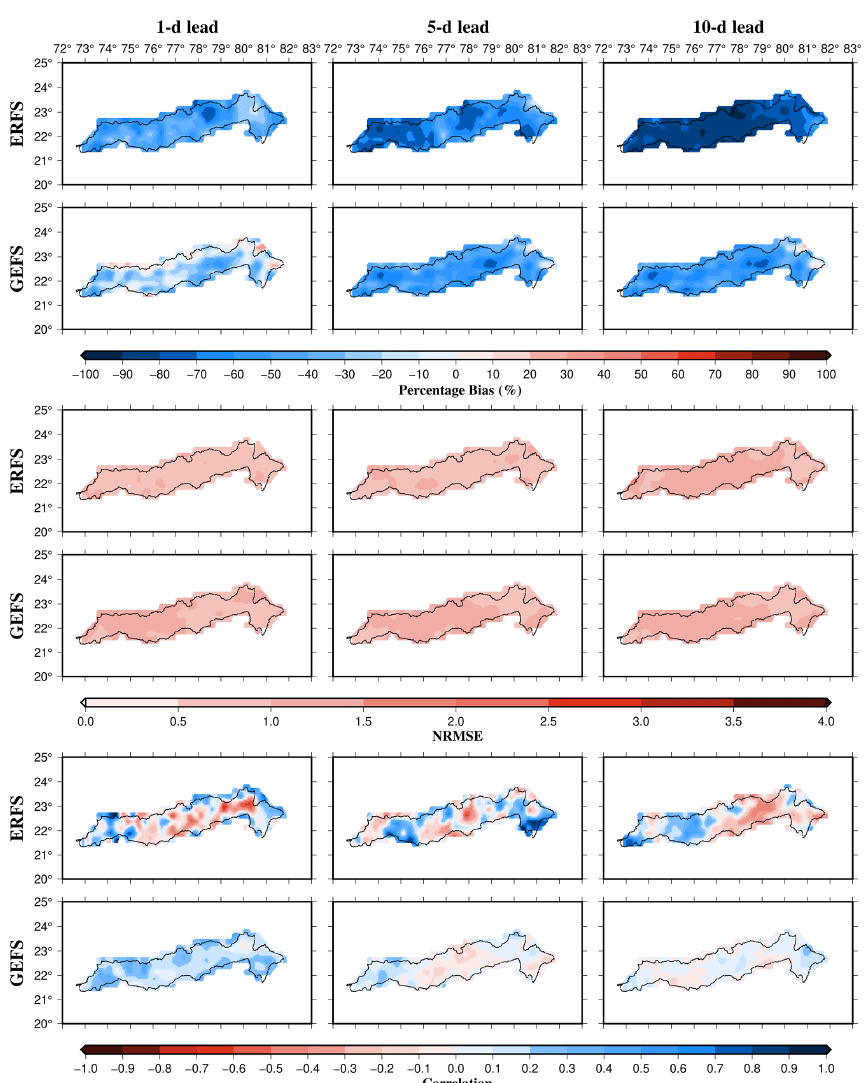
Figure 5. Comparison of the extreme precipitation (exceeding 75th percentile) forecast skills from ERFS and GEFS for the summer monsoon period during 2019–2020. Forecast skills were evaluated using bias, NRMSE, and correlation for each ensemble member of ERFS and GEFS and the median skill is